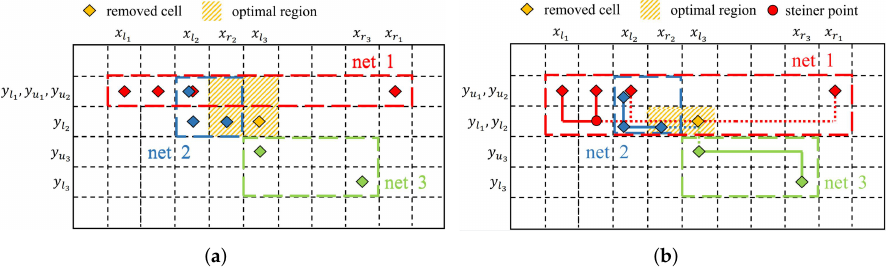
Figure 6. The optimal region obtained by: ( a ) the method presented in the work [5]. ( b ) the improved method in our